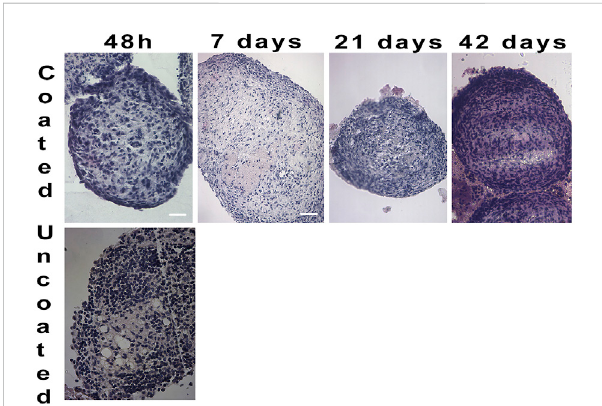
FIGURE 5 Hematoxylin/Eosin staining on cell spheroids transplanted in CD1 mice and retrieved at different time periods. After 48 h no un- coated spheroids were detected (4X). Coated spheroids were retrieved from CD1 mice throughout 42 days of graft, and histological staining showed well de fi ned and compact cell composition